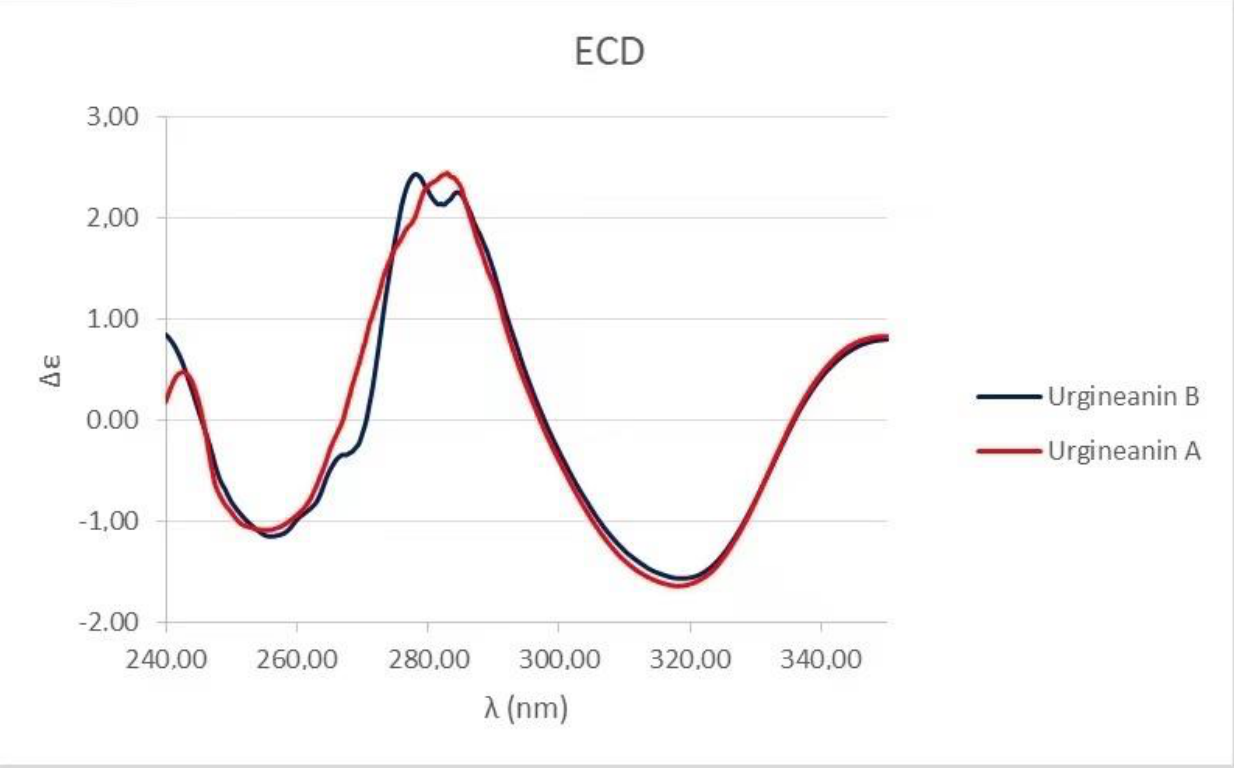
Figure 5. ECD spectra of homoisoflavanoids ( 2 ) (black solid line), and 3 (red